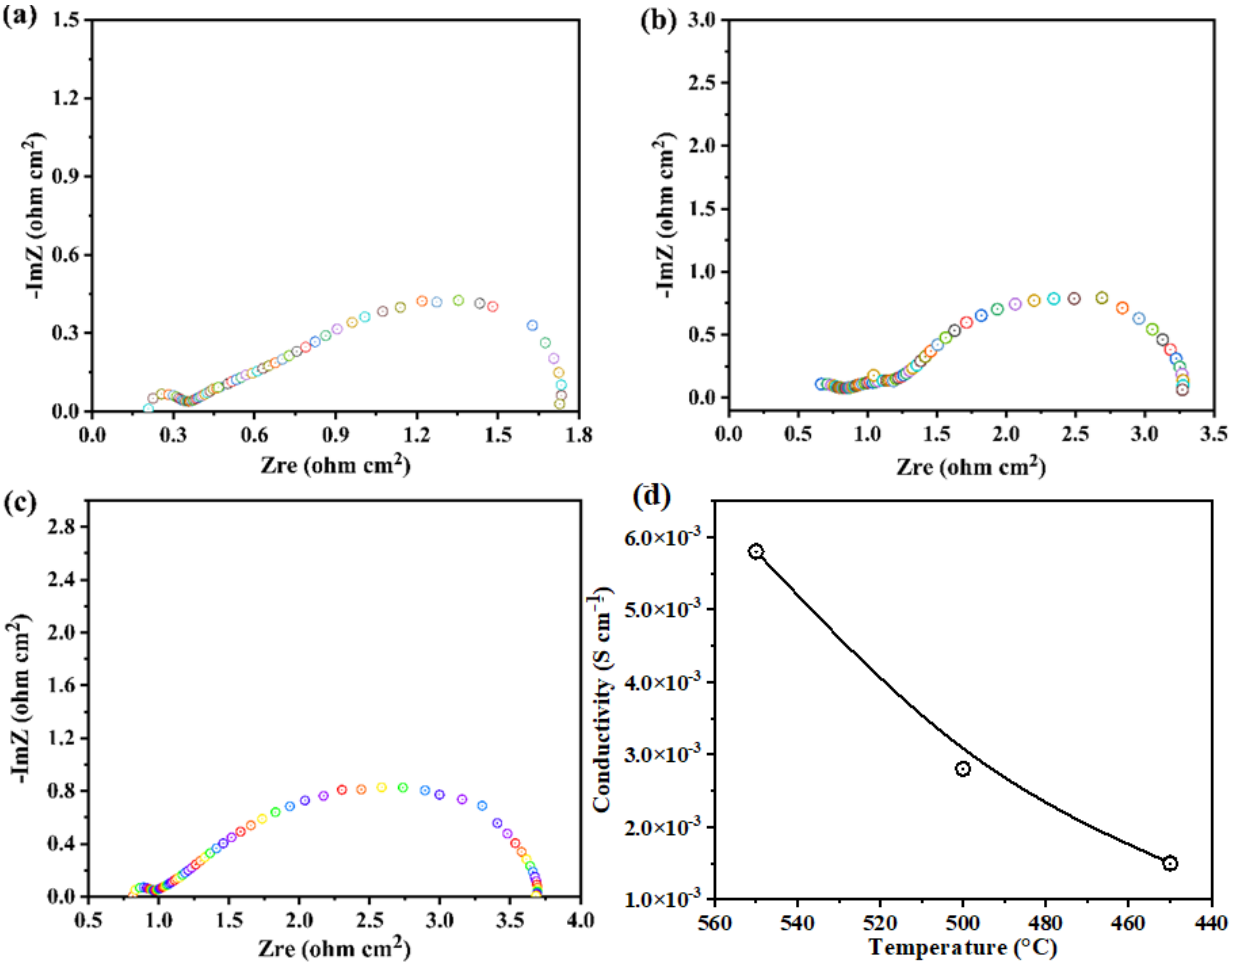
Figure 5. ( a – c ) Impedance spectra for the fuel cell prepared with the ZnO electrolyte layer measured in H 2 /air at 450 °C–550 °C, respectively, where different colors represent the data measured at different frequency. ( d ) Measured ionic conductivity of the ZnO electrolyte at 450 − 550 °C.